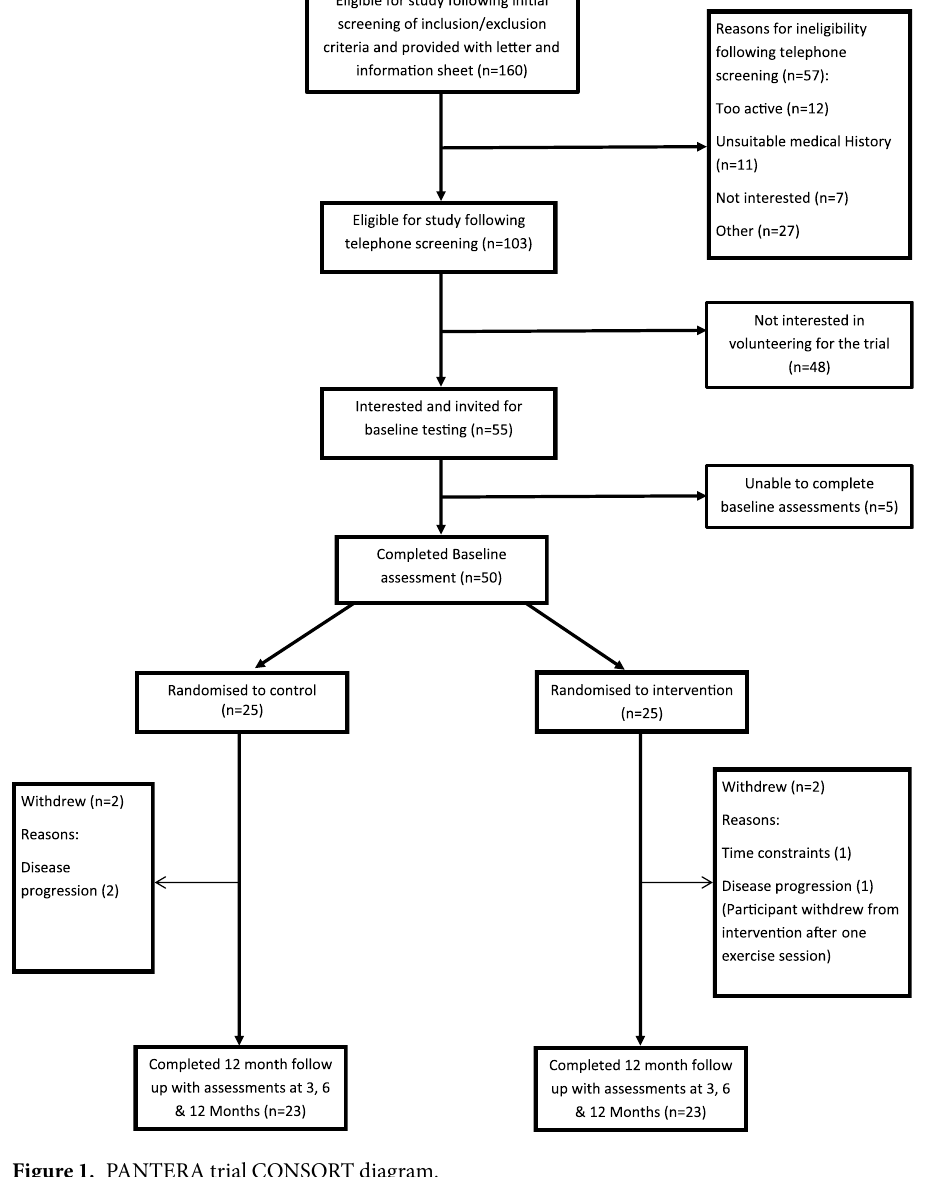
Figure 1. PANTERA trial CONSORT